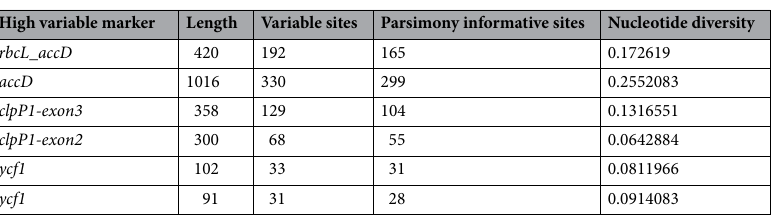
Table 3. Highly variable sequences (Pi > 0.06) of ten Ligustrum species.